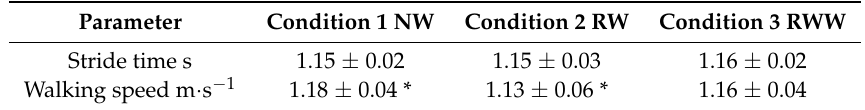
Table 1. Measured gait parameters. The values are reported as median ± median absolute deviation; * indicates a statistically significant difference in walking speed between conditions 1 and